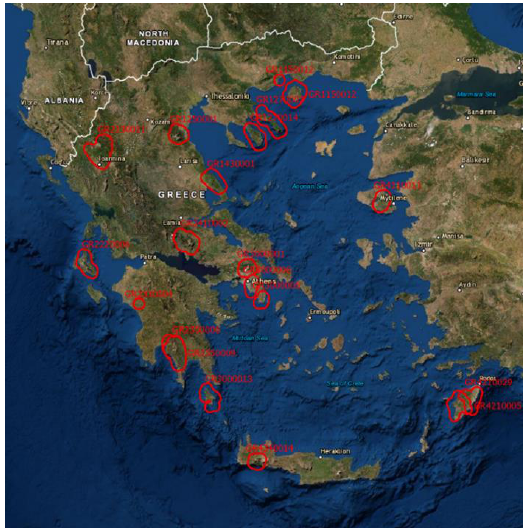
Figure 3. Map of the Areas of Interest (selected Natura 2000 areas buffered by 10 km).